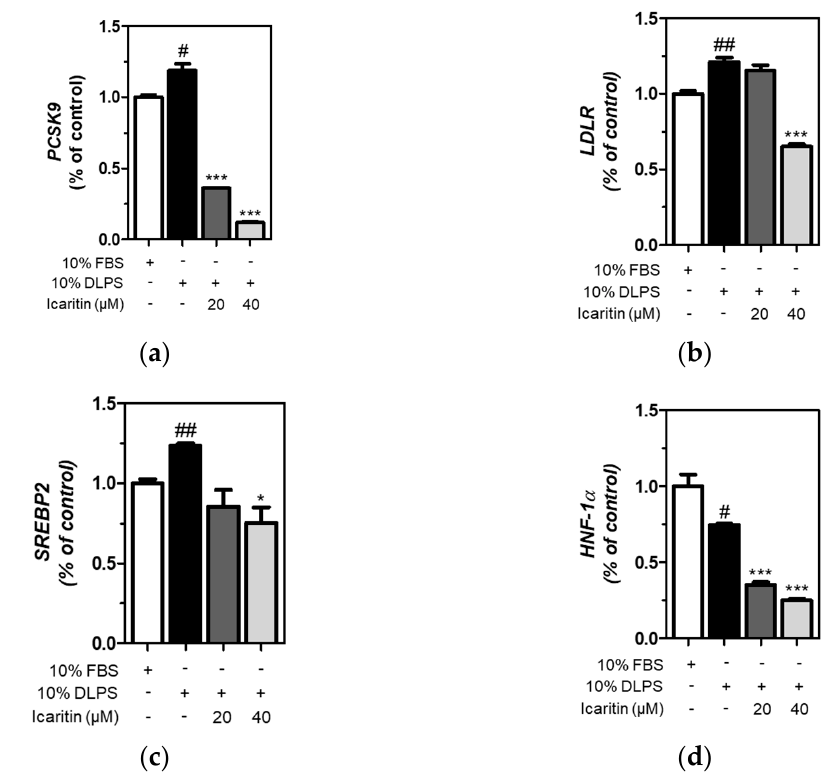
Figure 4. Expression of genes, including PCSK9 ( a ), LDLR ( b ), SREBP2 ( c ), and HNF-1 α ( d ) in HepG2 cells treated with fetal bovine serum (FBS) or DLPS in the presence or absence of icaritin (0, 20, 40 µM), measured using qRT-PCR. #; significant difference between cells treated with FBS and DLPS (Student’s t -test, # p < 0.05; ## p < 0.01). *; significant difference between cells treated with DLPS and compounds (Student’s t -test, * p < 0.05; *** p < 0.001).